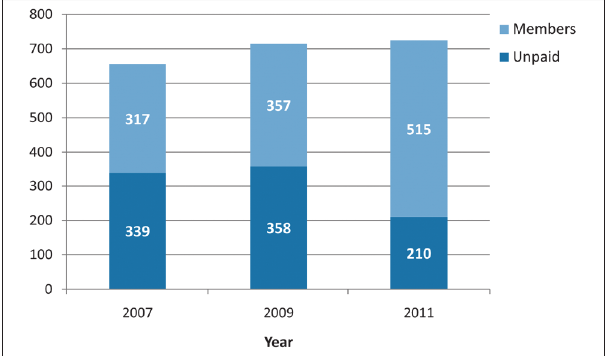
Fig. 1. Total number of psychiatrists registered as potential SASOP members.